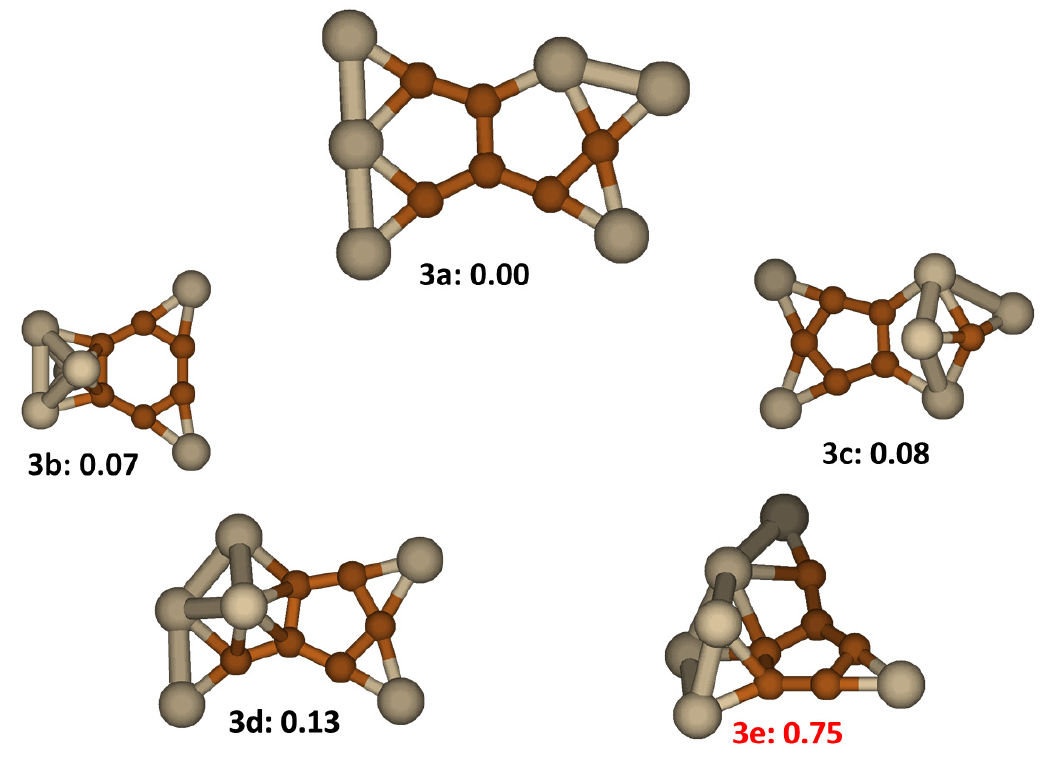
Figure 3. The structures and relative energies (in eV) of the lower energy Si Structure 3e is previously reported in ref.